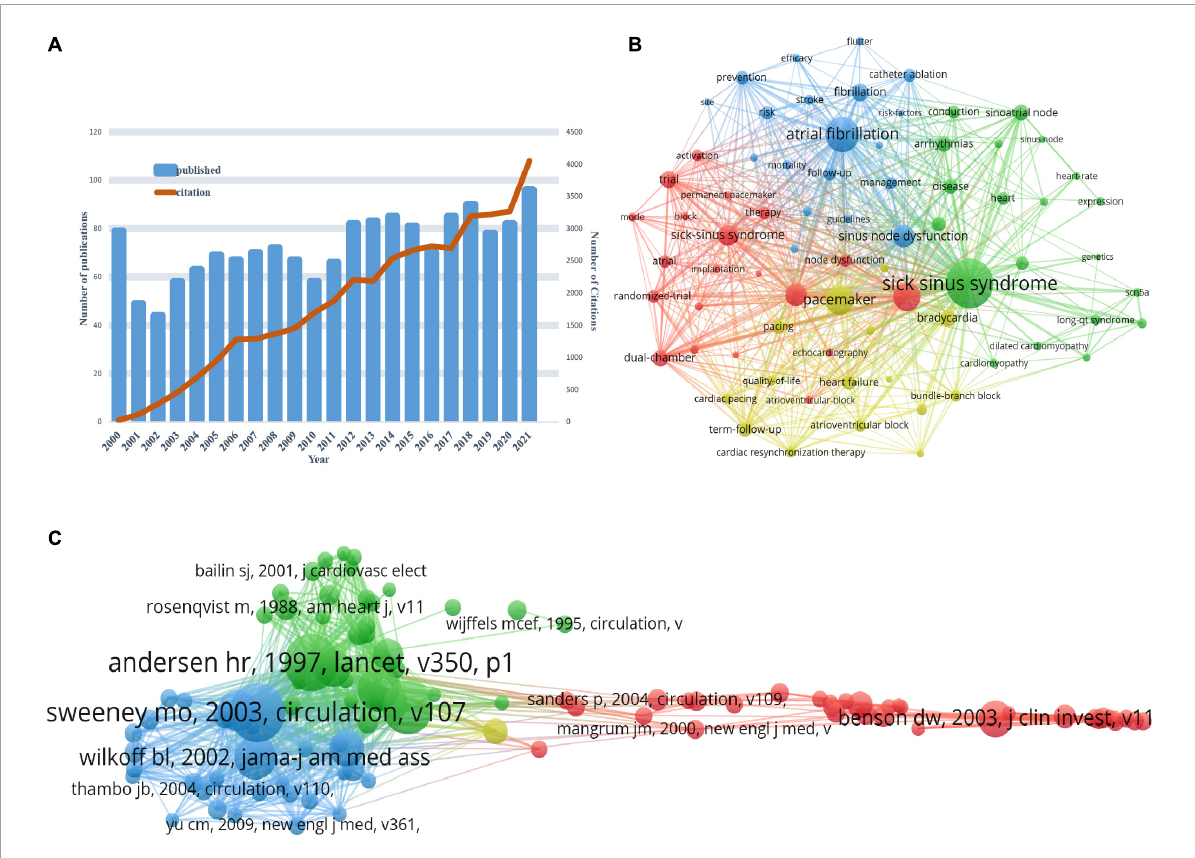
FIGURE8 (A) Global trend chart of annual publications and citations of the study on the correlation between SSS and atrial fibrillation from 2000 to 2022. (B) Network map of the keywords of SSS and atrial fibrillation based on VOS viewer. (C) Network map of the references of SSS and atrial fibrillation based on VOS